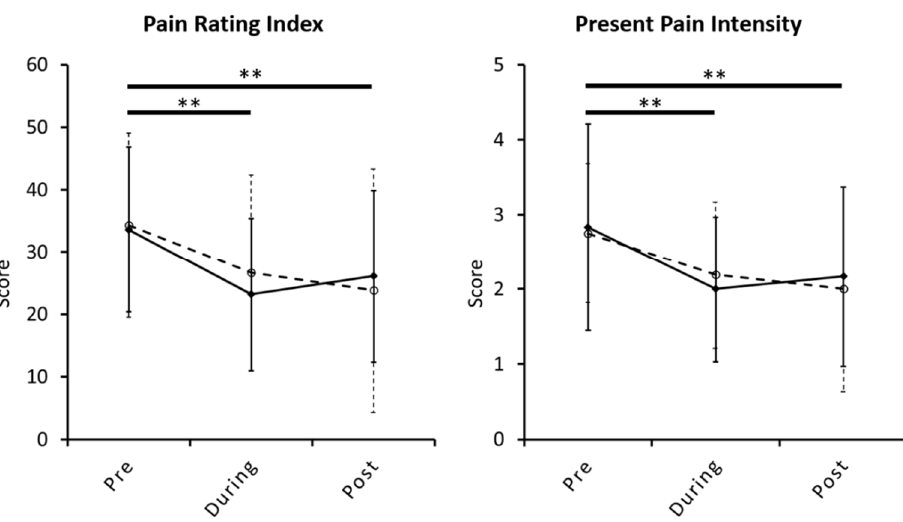
Figure 2. The changes in menstrual pain experience and intensity with verum or sham intervention in patients with primary dysmenorrhea. Both menstrual pain experience and intensity significantly decreased in the early stage of the intervention till the end of intervention session. The solid line and dash line denote verum and sham group, respectively. The double-asterisk mark denotes the significant difference with p < 0.01. Data is illustrated as mean ± SD. **, the significant difference with p < 0.01 Table 2. Menstrual pain experience, psychological assessment, and gonadal hormone level across acupuncture interven- tion.